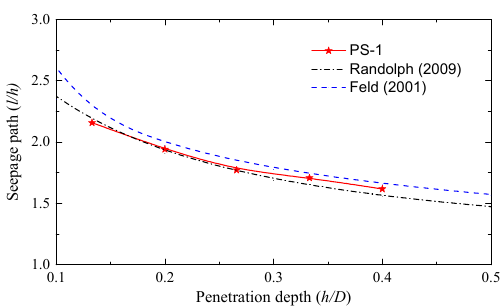
Figure 13. Relationship between the seepage path and penetration depth. J. Mar. Sci. Eng. 2020 , 8 , 368